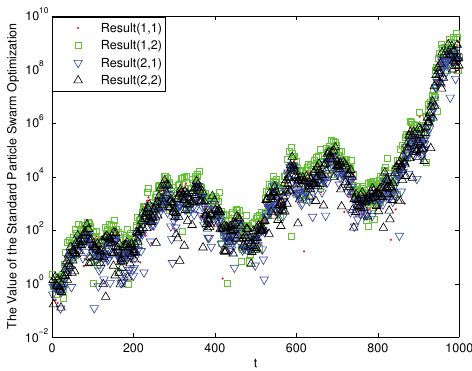
Figure 3: The elements in the accumulated matrix in the whole evolutionary process, where the constant inertia weight is set to 0.91 and acceleration coe ffi cients are selected to be 1.90. Additionally, Result ( i , j ) denotes the ( i , j ) element in the accumulated